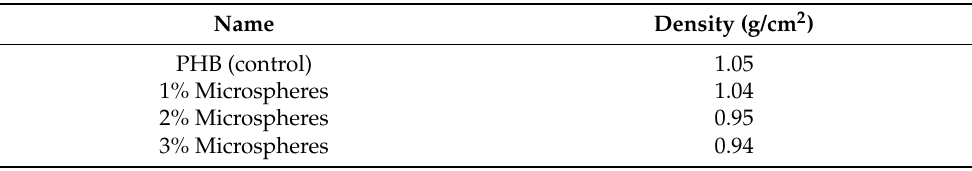
Table 1. Density of PHB/microsphere composites.